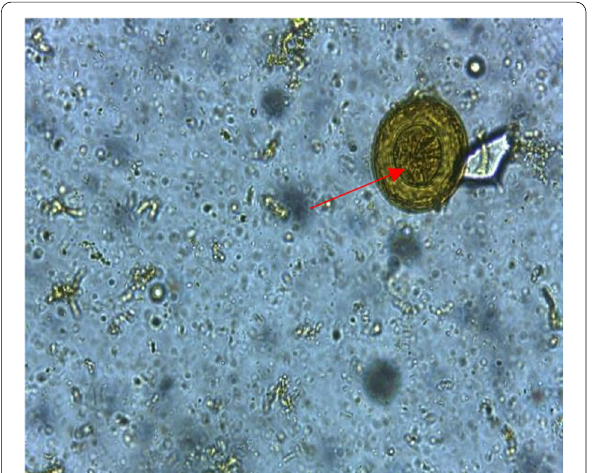
Fig. 5 Egg of Trichuris sp